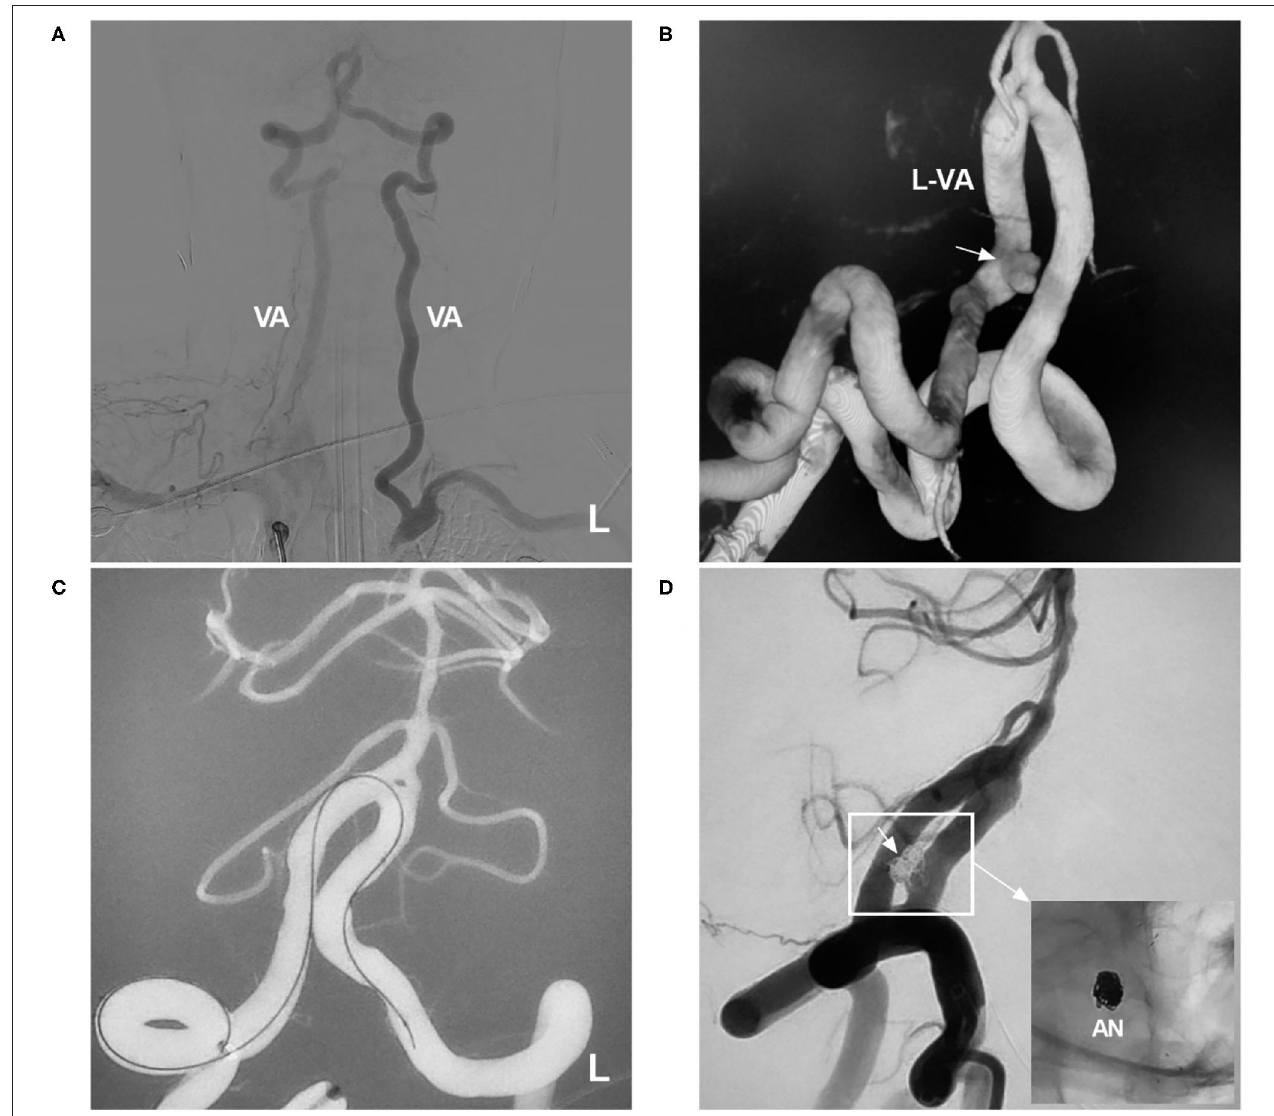
FIGURE 6 | Transcirculation NAS-assisted coiling of a VA aneurysm. (A) DSA of the right subclavian artery showing occlusion of the left subclavian artery, with the blood-stealing phenomenon from the VA to the subclavian artery. (B) Three-dimensional DSA of the VA showing the aneurysm (arrow) in the left VA. (C) NAS delivery microcatheter advances into the contralateral VA under the navigation of roadmap. (D) Postoperative DSA of the VA showing complete occlusion of the aneurysm (arrow); the magnified inset (long arrow from the frame) shows NAS-assisted coiling of the aneurysm (AN). AN, aneurysm; DSA, digital subtraction angiography; L, left; NAS, Neuroform Atlas stent; VA, vertebral